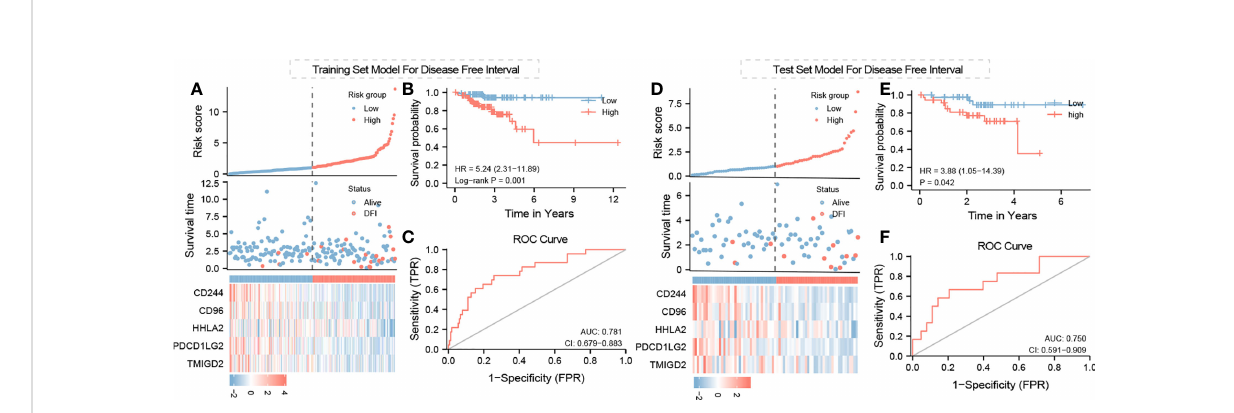
FIGURE 5 Training and test set model for DSS, PFS, and OS: risk score survival time and immunomodulator expression pro fi les regarding Col10A1 expression and risk group relation for (A) training set model and (D) test set model; (B, E) Kaplan – Meier curve for training set and test set model; (C, F) ROC curve for test model validation and optimization of training and test set